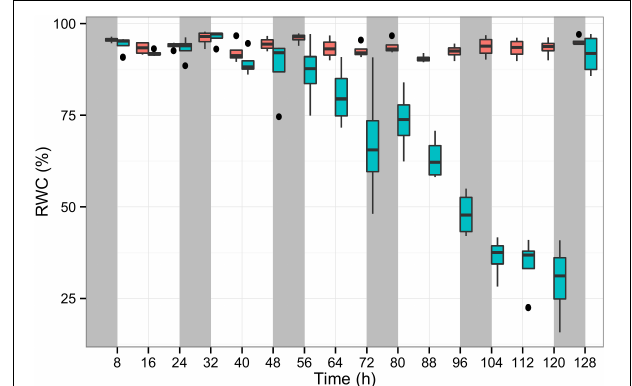
FIGURE 2 | The relative water content (RWC) of perennial ryegrass plants measured in at least two leaf tissue samples per plant. The blue boxplots show the RWC values of seven experimental plants subjected to water deprivation for 130 h and after re-watering. The red boxplots show 15 well-watered control plants along the same experimental duration (x-axis). Night periods are indicated with gray